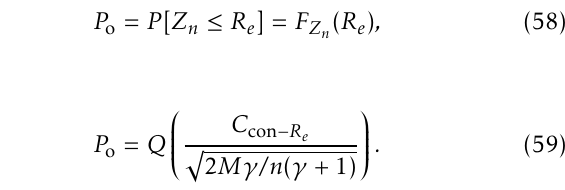
for QPSK, code rate R o